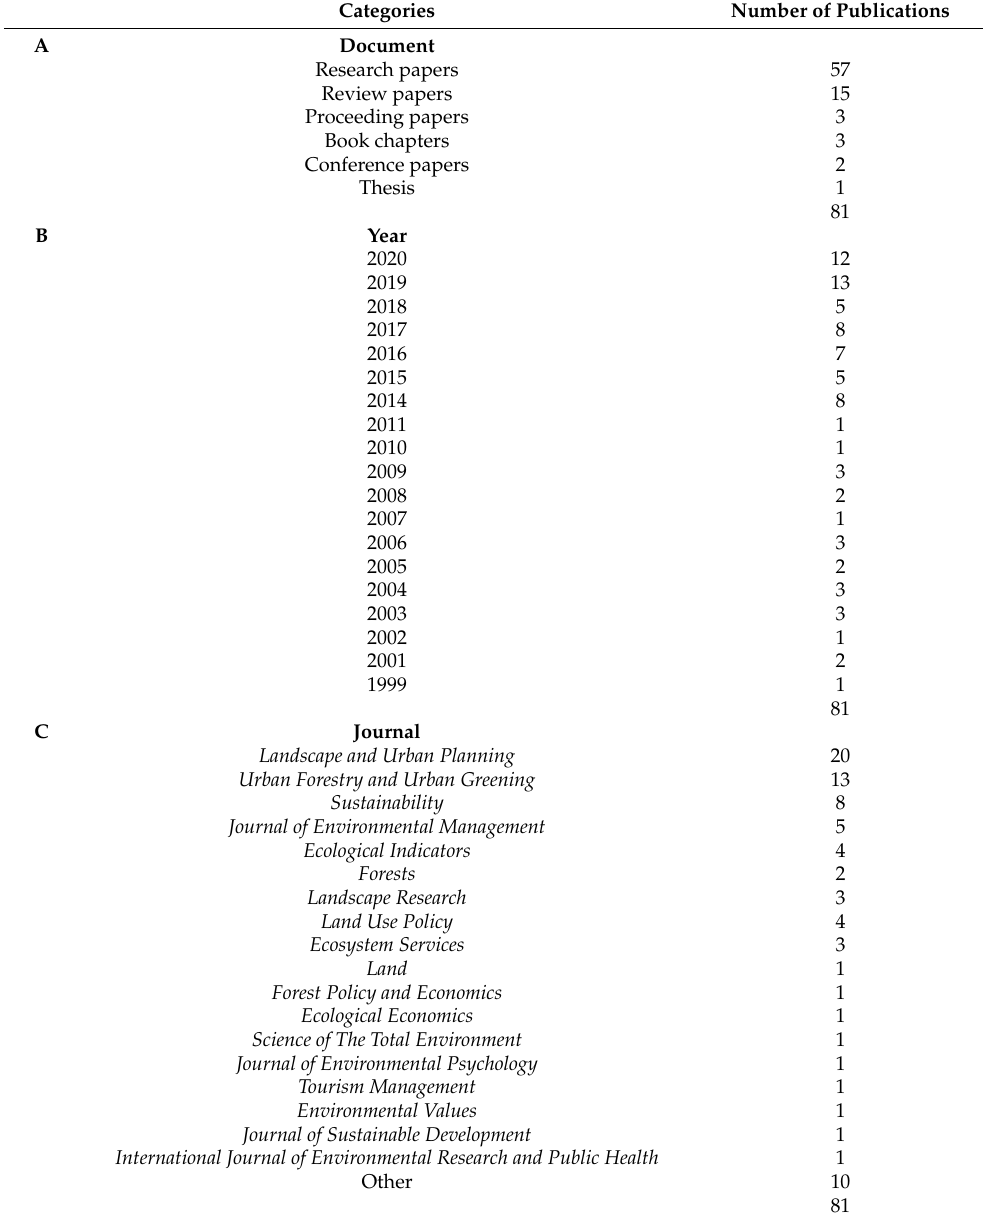
Table A2. Total number of publications from all 81